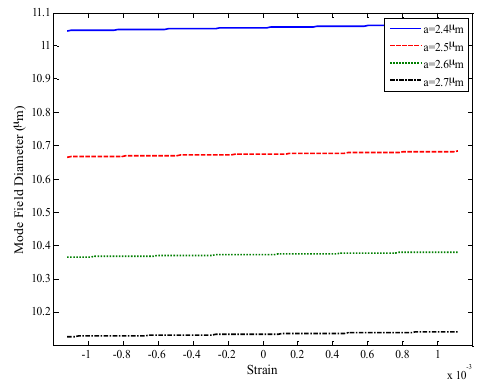
Figure 3. Mode field diameter vs. strain for the core radius as